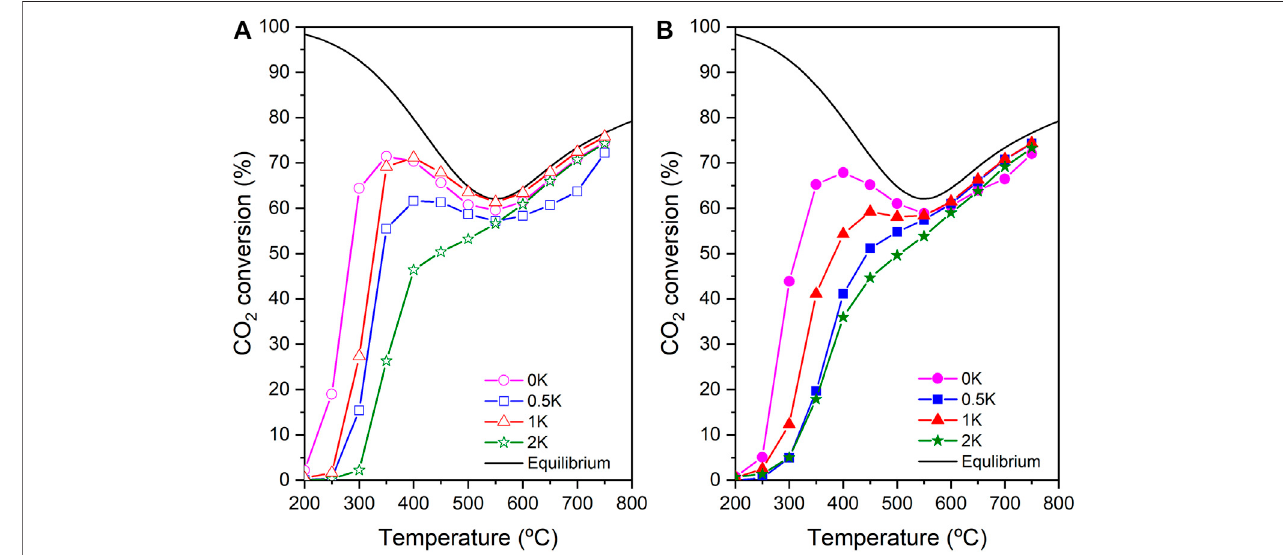
FIGURE 7 | CO 2 conversion of the (A) non-reduced catalysts and (B) reduced catalysts.